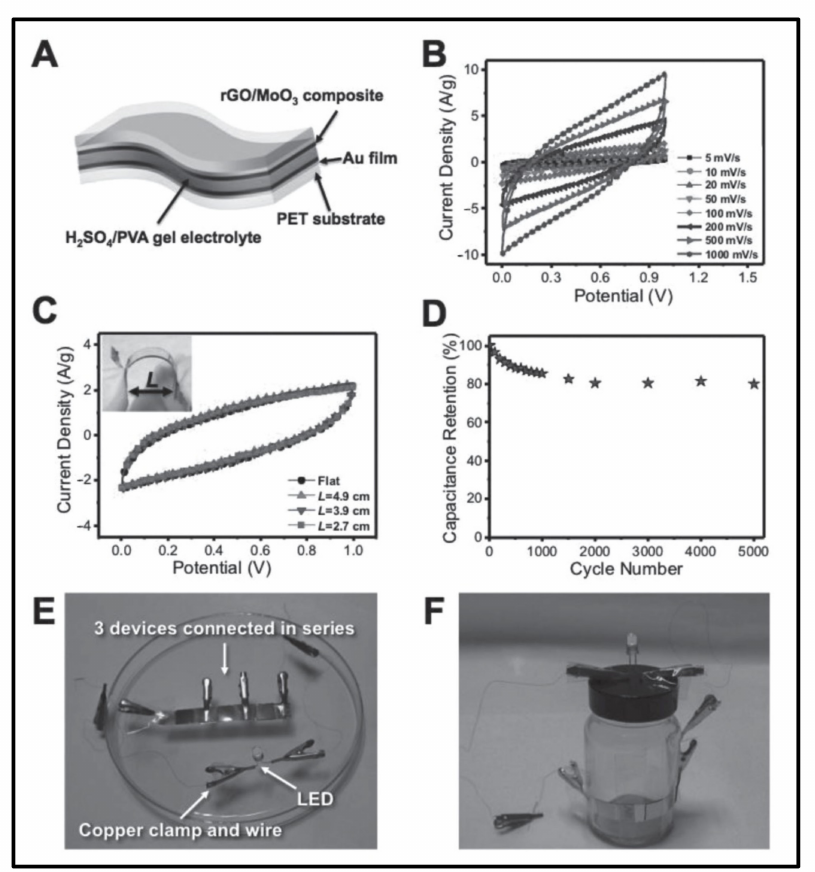
Figure 8. Electrochemical performance pf the all-solid-state flexible supercapacitor device fabricated with rGO/MoO 2 composite, ( A ) Schematic illustration of the configuration of fabricated device, ( B ) CV curves of the device at different scan rates, ( C ) CV curves of the device under different bending status, ( D ) cycling performance measured by charging and discharging the device at 2 A/g for 5000 cycles, ( E , F ) real photographs of the device [33]. Reprinted with permission from Cao, Xiehong, et al. Reduced graphene oxide-wrapped MoO 3 composites prepared by using metal- organic frameworks as precursor for all-solid-state flexible supercapacitors, Adv. Mater. 2015, 27, 32, 4695–4701. Copyright © 2015 WILEY-VCH Verlag GmbH & Co. KGaA, Weinheim